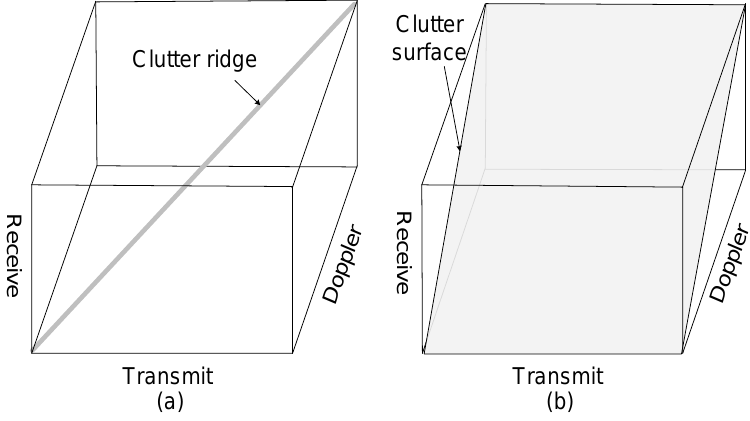
Figure 3. Clutter distribution in transmit–receive–Doppler space for ( a ) ideal MIMO orthogonal; ( b )